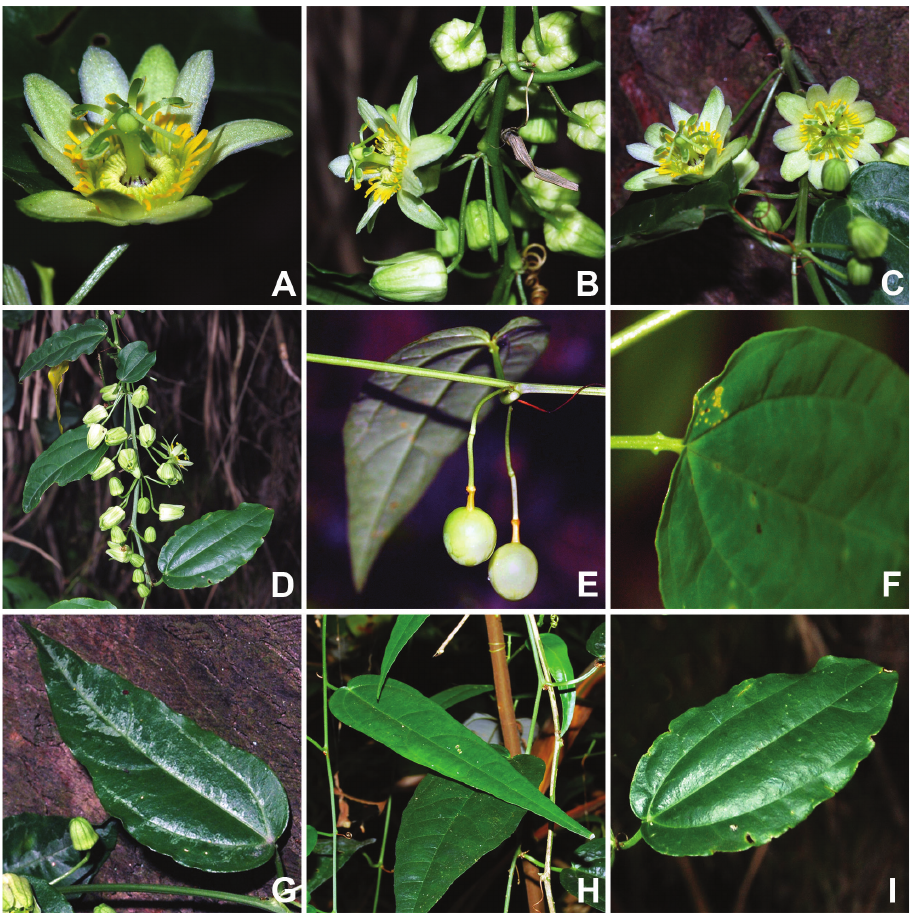
Figure 2. Floral and vegetative features of P assiflora kwangtungensis . A flower at anthesis B side view of open flower within inflorescence, three axillary inflorescences shown C arrangement of two flowers within axillary inflorescence D congested arrangement of individual axillary inflorescences, each with two to six flowers per inflorescence e immature fruit F papillate petiolar nectaries G mottled variegation along ma- jor veins in young leaf h lanceolate leaf shape associated with young growth i ovate leaf shape observed on older tissues. Photo credits: Xun-Lin